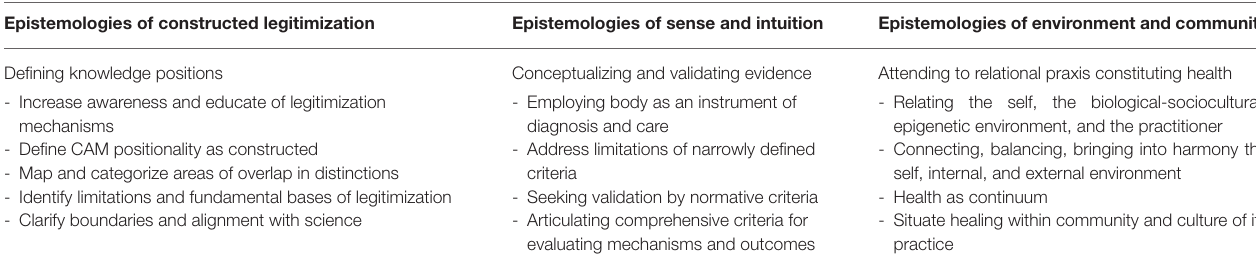
TABLE 2 | CAM provider knowledge discourse of holistic health. Epistemologies of constructed legitimization Epistemologies of sense and intuition Epistemologies of environment and community Defining knowledge positions Conceptualizing and validating